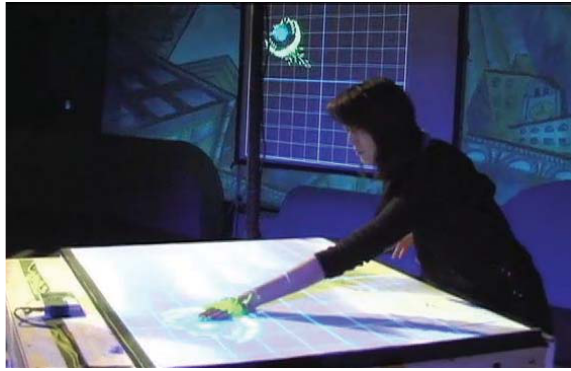
Figure 1. Dynamic Score performance application in